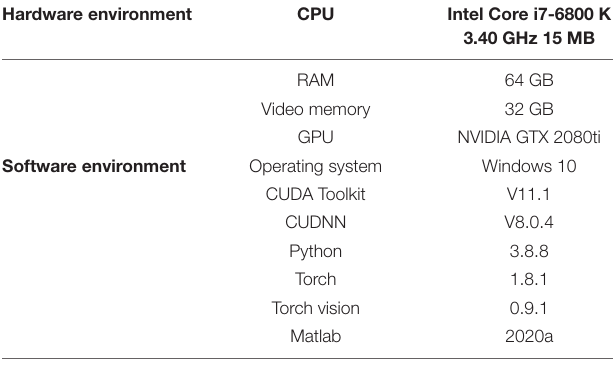
TABLE 3 | Parameter